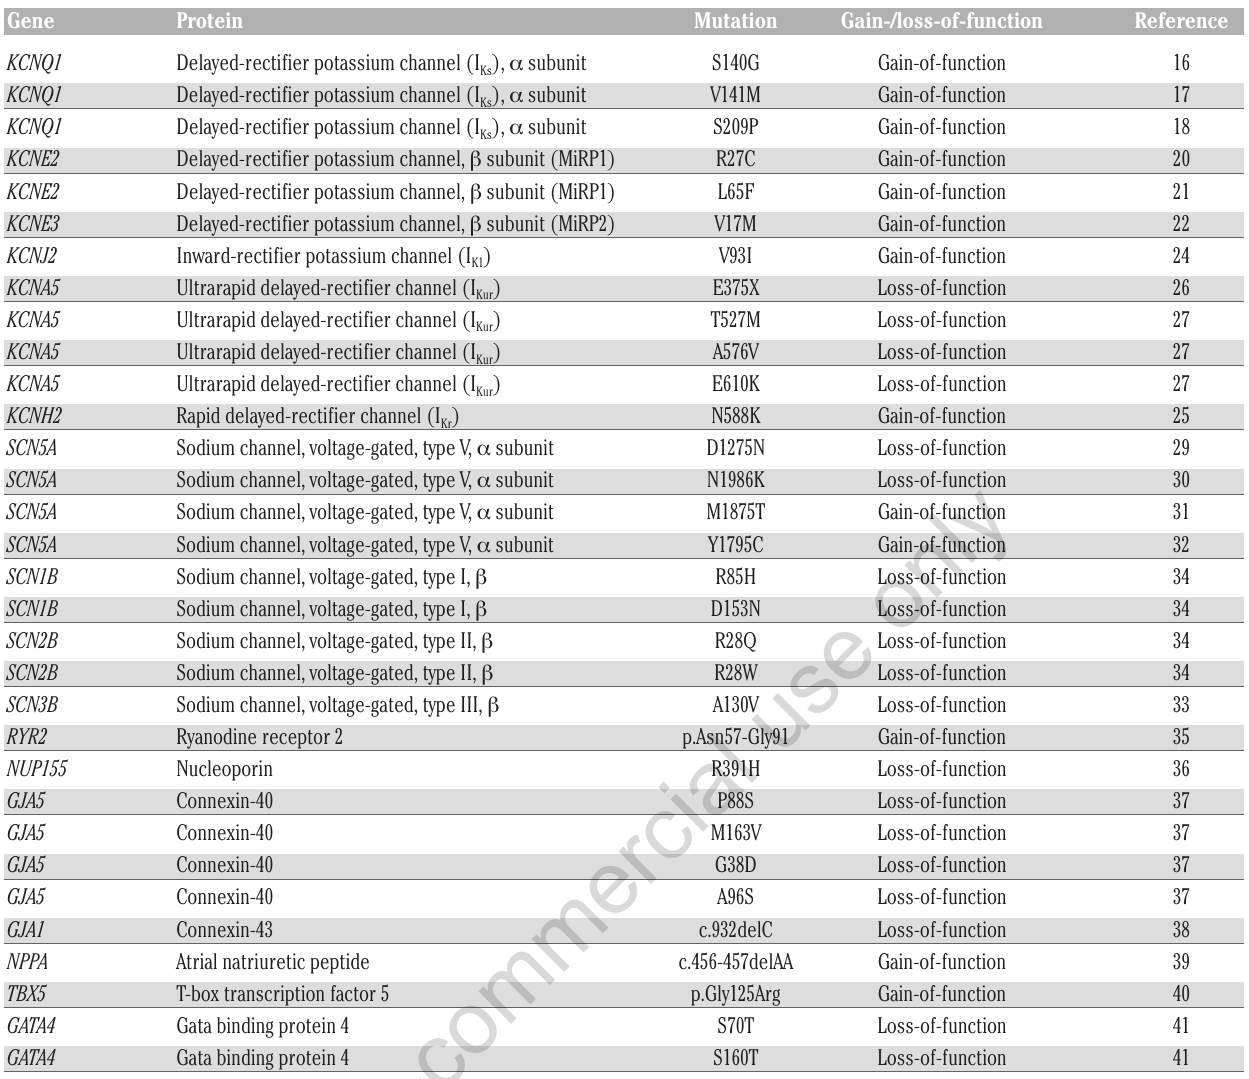
Table 1. Mutations associated with monogenic forms of atrial fibrillation. Gene